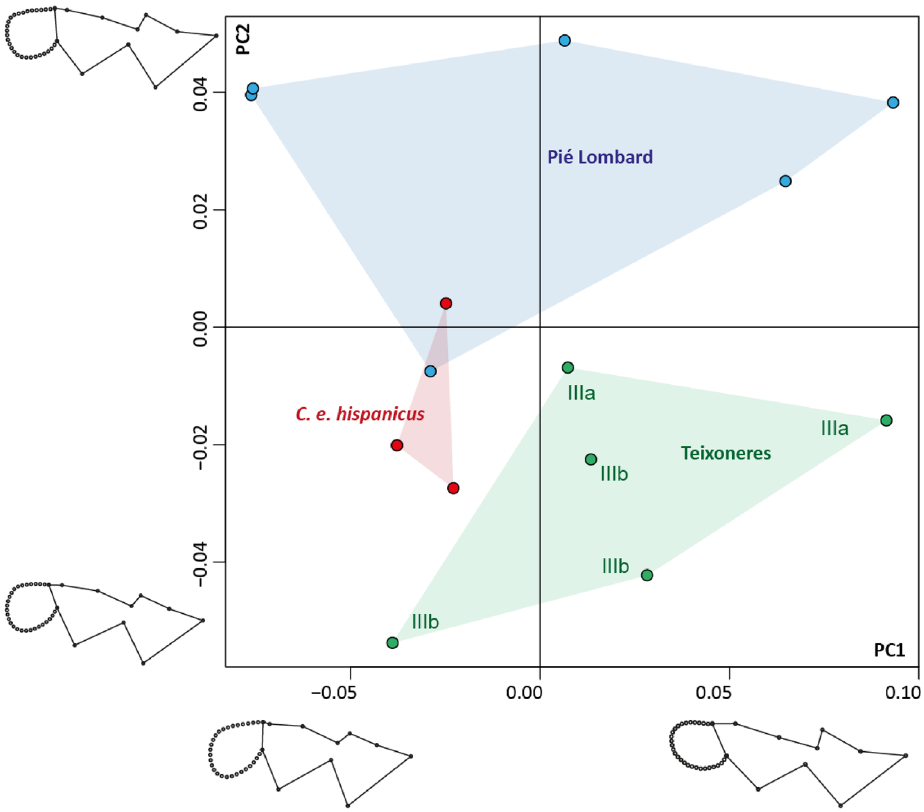
Figure 3. Principal components (PC) scatterplot between PC1 (48.16%) and PC2 (17.86%) performed on the shape data of the m3 according to the population (Teixoneres Unit IIIa and IIIb, Pié Lombard and current C. e. hispanicus ) with a visualization of shape variation along PC1 and